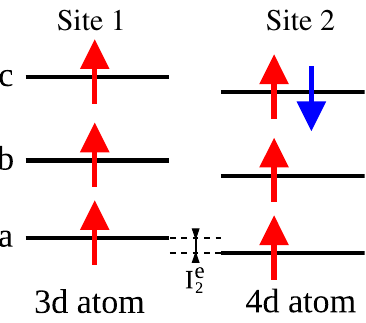
FIG. 3. Schematic representation of one configuration belong- ing to the manifold of 36 degenerate ground states for a representative 3 d − 4 d bond as given by the local Coulomb m Þ (6) with m ¼ 1 , 2. The dominant exchange Hamiltonian H int ð processes considered here are those that move one of the four electrons on the 4 d atom to the 3 d neighbor and back. The stability of the 3 d 3 - 4 d 4 charge configurations is provided by the local potential energy I e 2 ; see Eq.